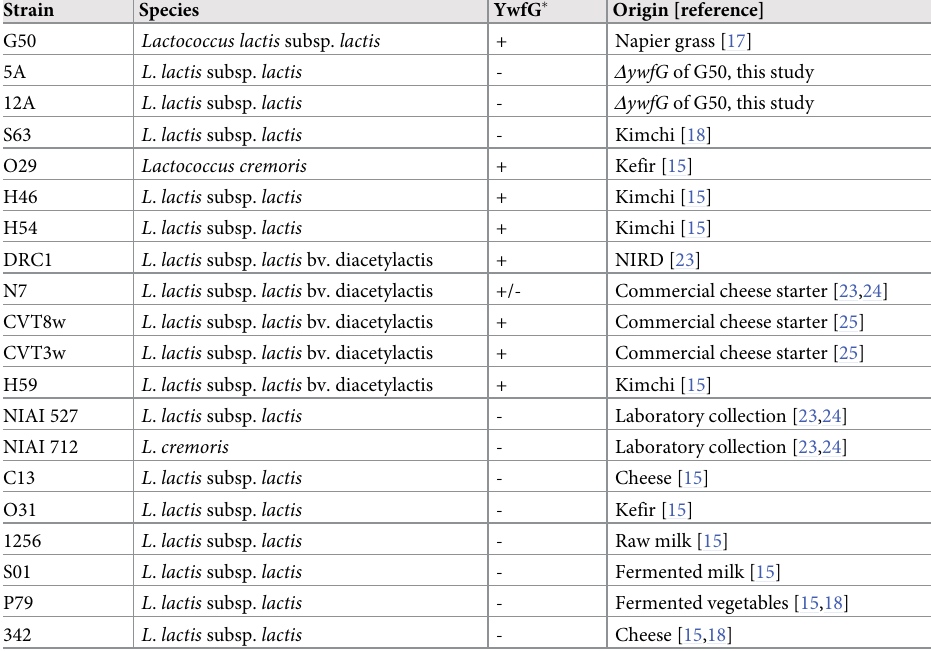
Table 1. Lactococcal strains used in this study.